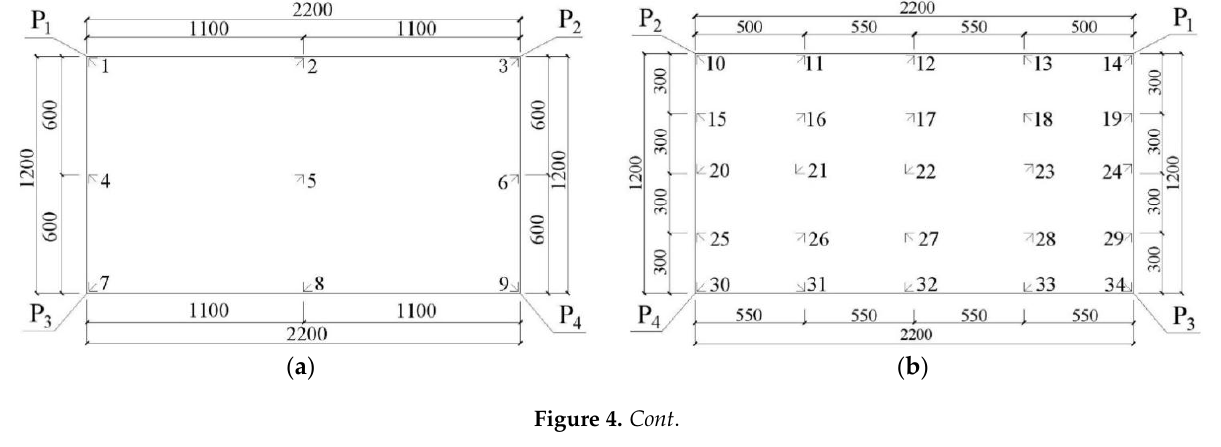
Figure 3. Real diagram during the tests. ( a ) Cold-bending tests; ( b ) Uniform load tests; ( c ) Ultimate capacity